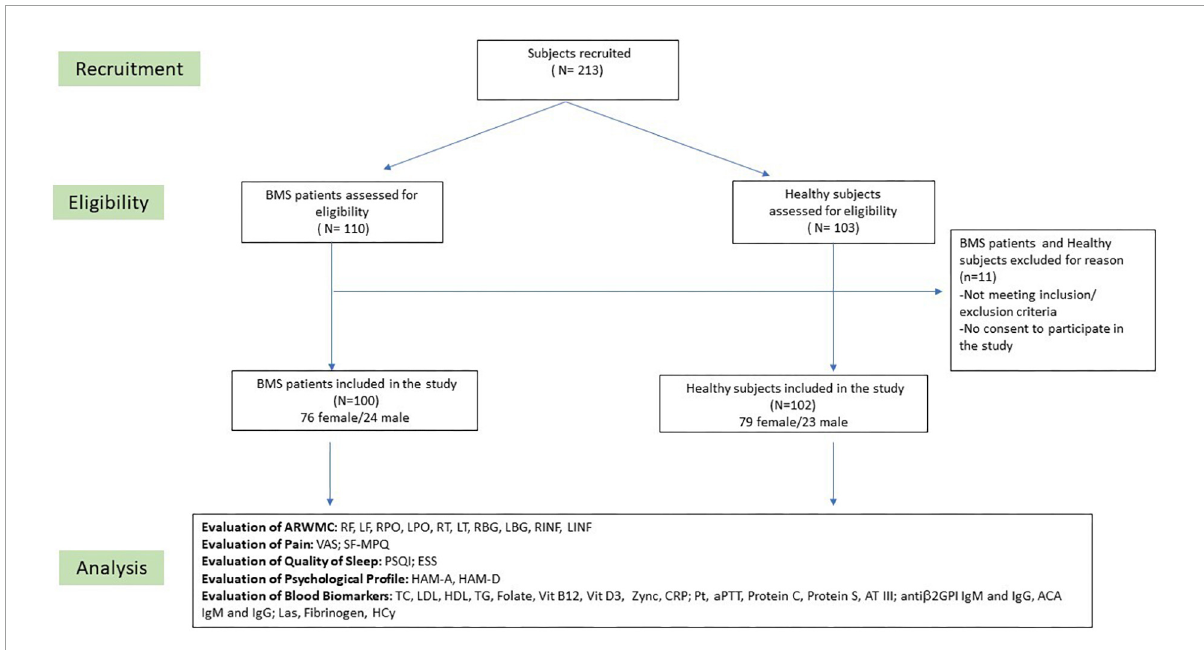
FIGURE1 Flow chart of the study. BMS, Burning Mouth Syndrome; ARWMC, Age Related White Matter Changes; RF, right frontal; LF, left frontal; RPO, right parieto-occipital; LPO, left parieto-occipital; RT, right temporal; LT, left temporal; RBG, right basal ganglia; LBG, left basal ganglia; RINF, right infratentorial; LINF, left infratentorial; VAS, Visual Analog Scale; SF-MPQ, Short-Form McGill Pain Questionnaire; PSQI, Pittsburgh Sleep Quality Index; ESS, Epworth Sleepiness Scale; HAM-A, Hamilton Anxiety Rating Scale; HAM-D, Hamilton Depression Rating Scale; TC, total cholesterol; LDL, low-density lipoprotein cholesterol; HDL, high-density lipoprotein cholesterol; TG, triglycerides; CRP, C-reactive protein; PT, prothrombin time; aPTT, partial thromboplastin time; AT III, plasma antithrombin III; Anti β 2GPI, anti- β 2-glycoprotein I antibodies; ACA, anti-cardiolipin antibodies; Las, lupus anticoagulants; Hcy,